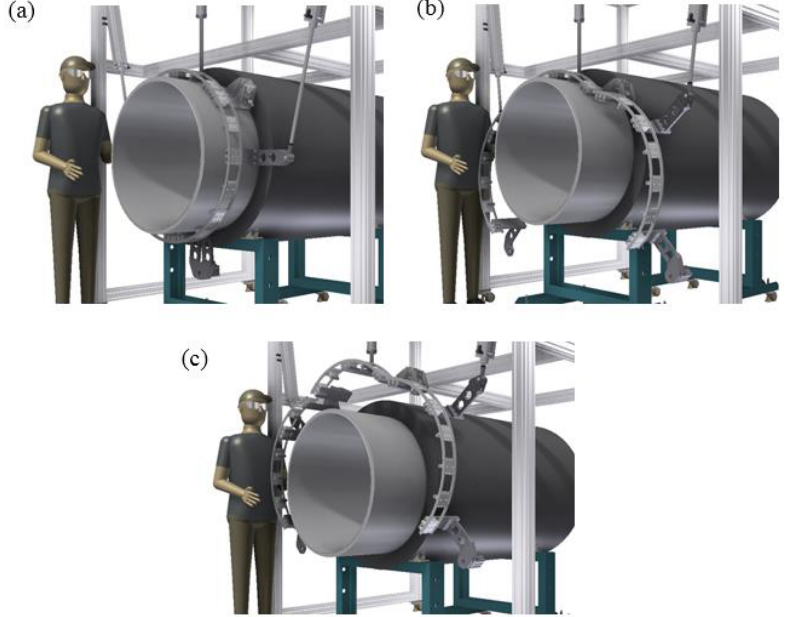
Figure 12. Installation of the guide track for pipe welding with a pneumatic system: ( a ) Locking the guide track, ( b ) unlocking the guide track, ( c ) disassembling the guide track from the pipe and moving to the next station.